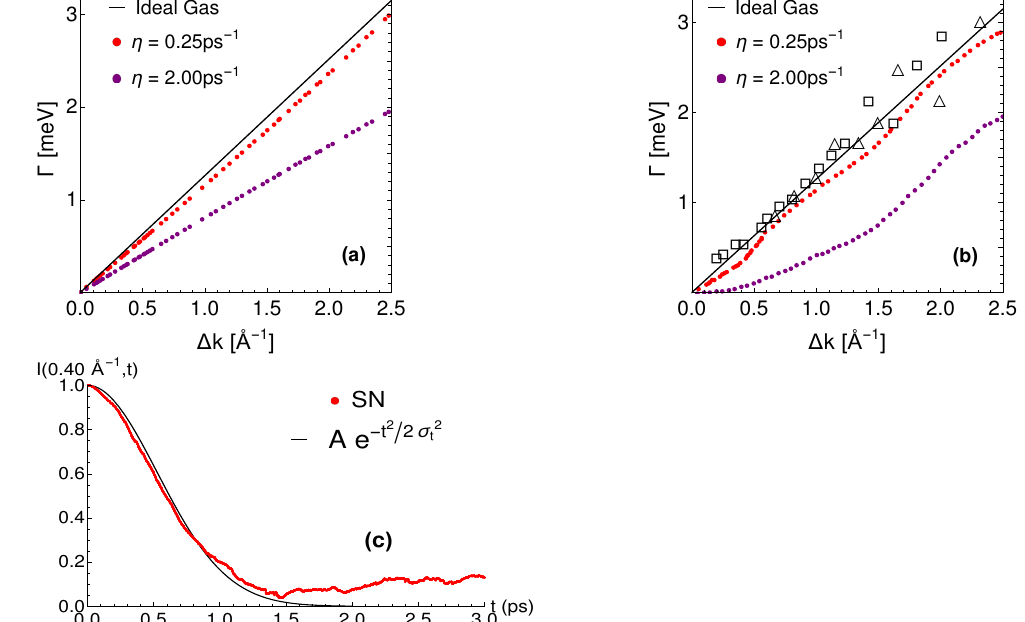
Figure 2. Quasielastic broadening Γ from Equation (44) as a function of surface parallel wave vector transfer ∆ k x for the decay process of the function I ( ∆ k , t ) with a low coverage θ = 0.017, surface temperature T = 105 K and initial adsorbate velocity v 0 = 115 m/s. Black lines correspond to Equation (45). ( a ) Numerical simulations for a flat surface ( V = 0 meV) with friction coefficients η = 0.25 ps − 1 (red) and η = 2.0 ps − 1 (purple). ( b ) Langevin molecular dynamics simulations from Ellis et al. [20]. Experimental results from the QHAS broadening at two incident He beam energies E i = 10.15 meV (triangles) and E i = 26.85 meV (squares). ( c ) The ISF given by Equation (41) is − 1 plotted versus the simulation time in ps for ∆ k = 0.40Å and friction coefficient η = 0.25 ps − 1 . Our simulation results (SN) are represented by the red curve and the fitting Gaussian function e − t 2 /2 σ 2 t by the black